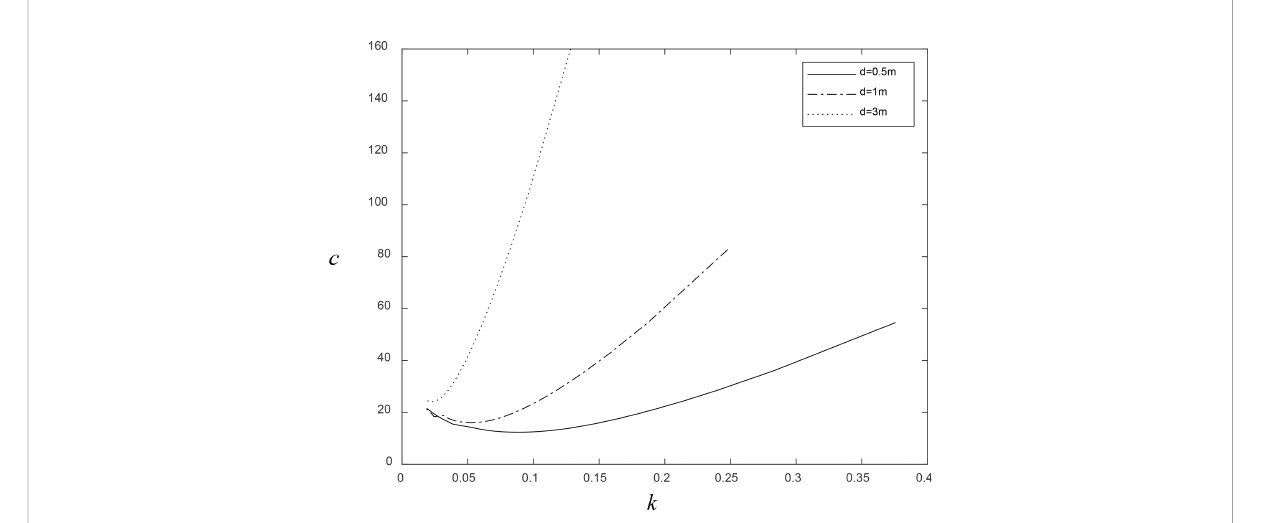
FIGURE 1 Nonlinear dispersion curve under various thicknesses of the ice sheet d = 0.5, 1, 3 m for water depth h = 100